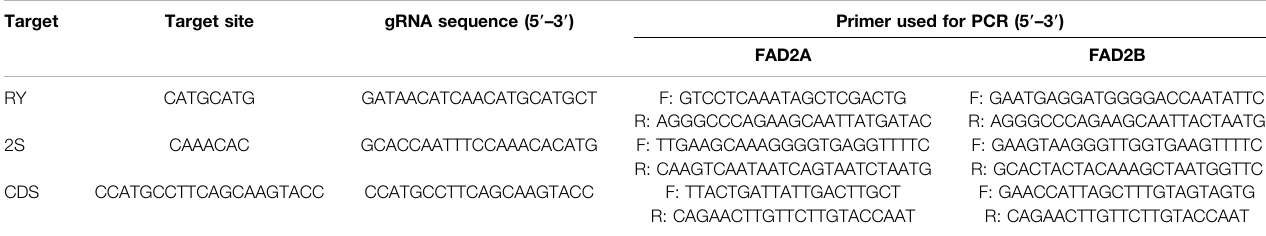
TABLE 1 | Genomic target site, gRNA and PCR primer information used in hairy root